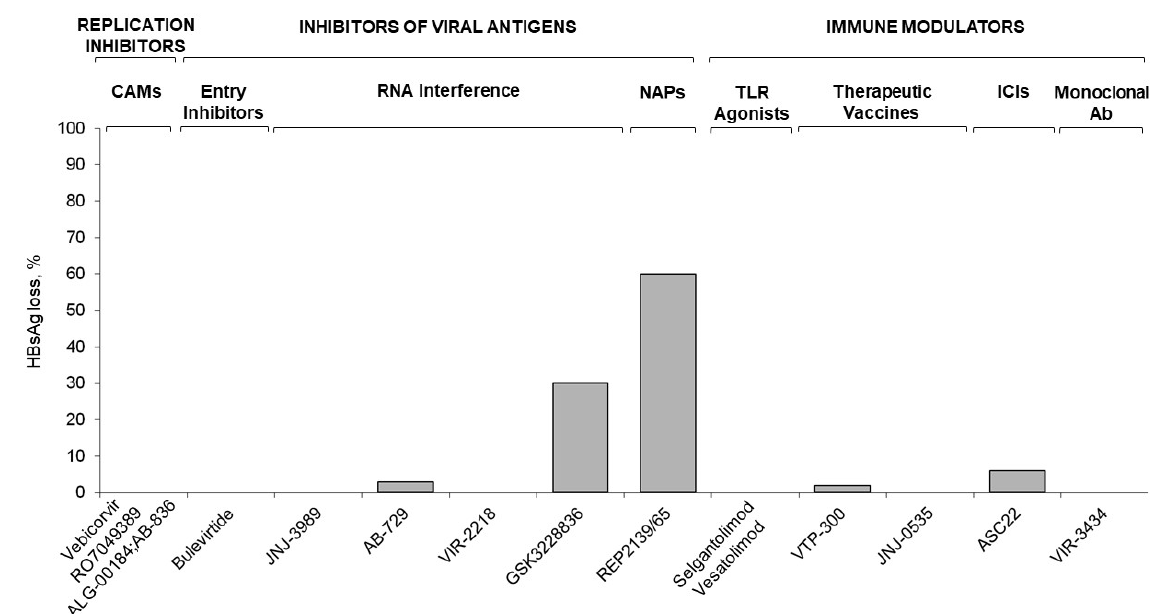
Figure 3. Rates of end-of-treatment HBsAg loss across the main investigational HBV drugs.